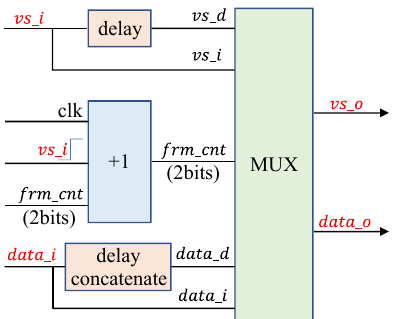
Figure 7. Signal and data regeneration